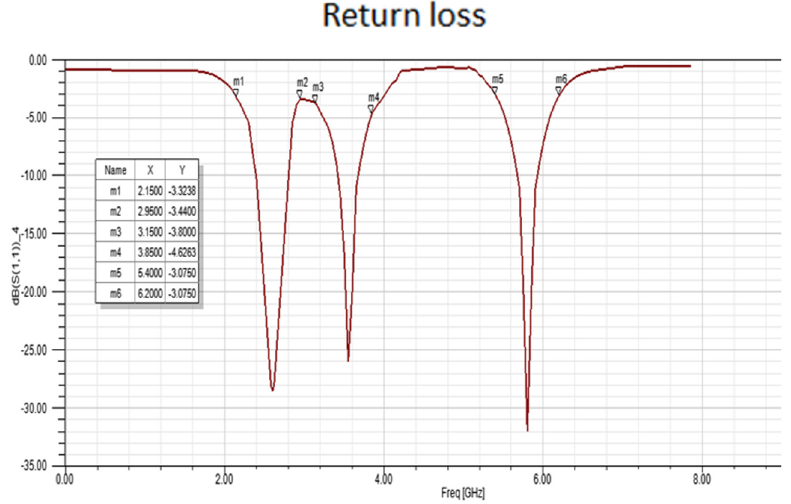
Figure 11. Measured [S11] parameters of the proposed antenna.